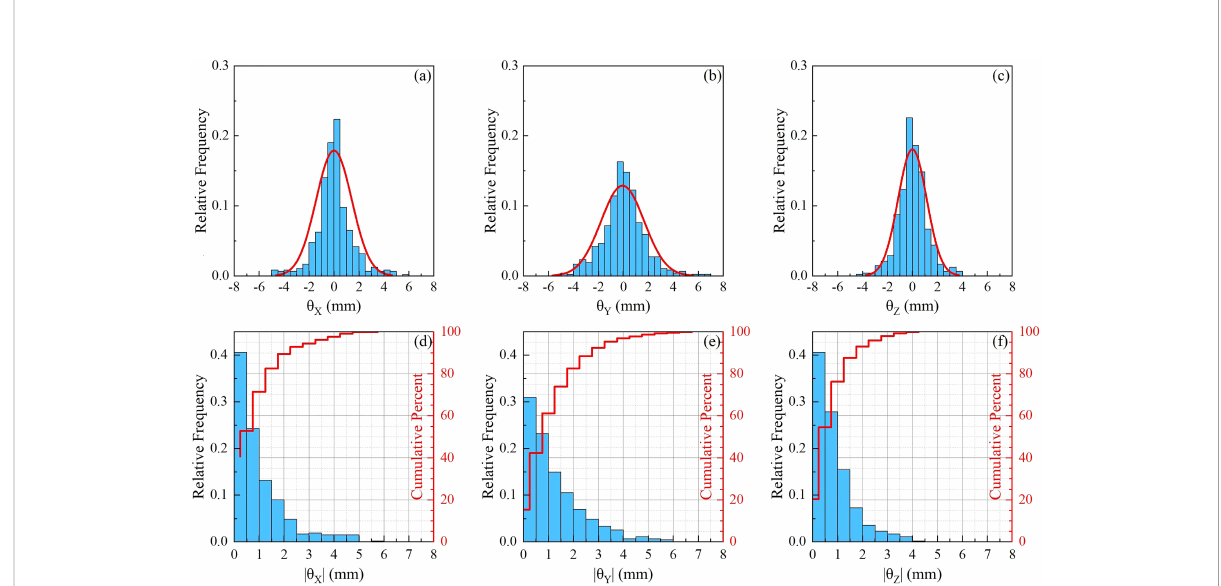
FIGURE 3 Statistics for rotational movements. (A – C) are normalized frequency histograms of rotational movements around LR ( q X ), AP ( q Y ) and SI ( q Z ) axes, respectively. The red curves are a Gaussian function fi tting for the histograms. (D – F) are normalized histograms (blue bars) and cumulative percent distribution (red histograms) with different absolute rotation angles around LR, AP and SI